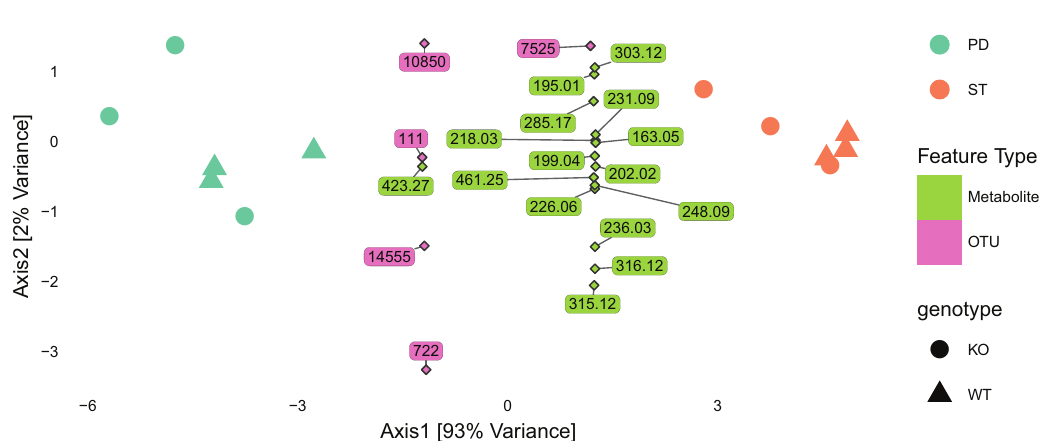
Figure 29. A PCA triplot produced from the CCA selected features in from muliple data types (metabolites and OTUs). Note that we have departed from our convention of fixing the aspect ratio here as the second axis represents very little of the variability and the plot would actually become